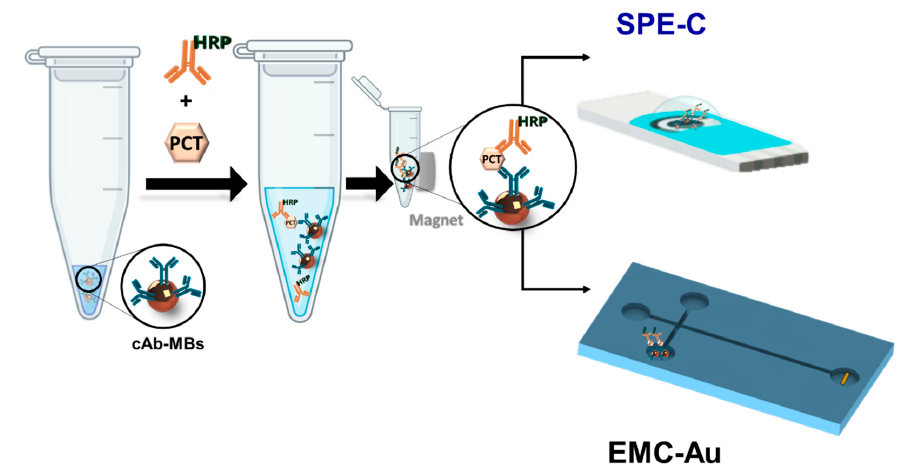
Figure 1. Magnetic bead-based electrochemical immunoassays—on-drop screen-printed carbon electrodes (SPE-C) and on-chip electro-kinetically driven microfluidic chips with integrated Au electrodes (EMC-Au).